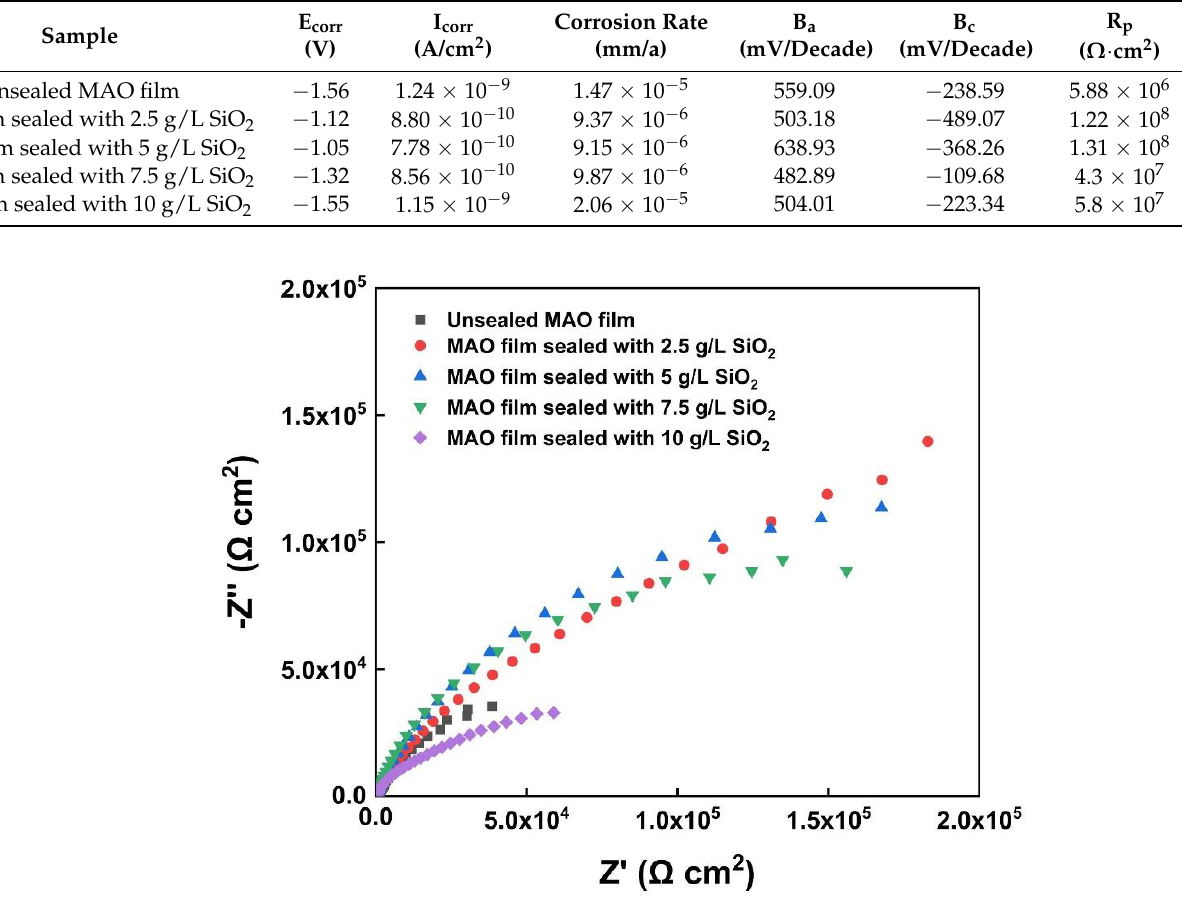
Figure 9. Nyquist plots of unsealed MAO film and MAO films sealed by SiO 2 nanoparticles.